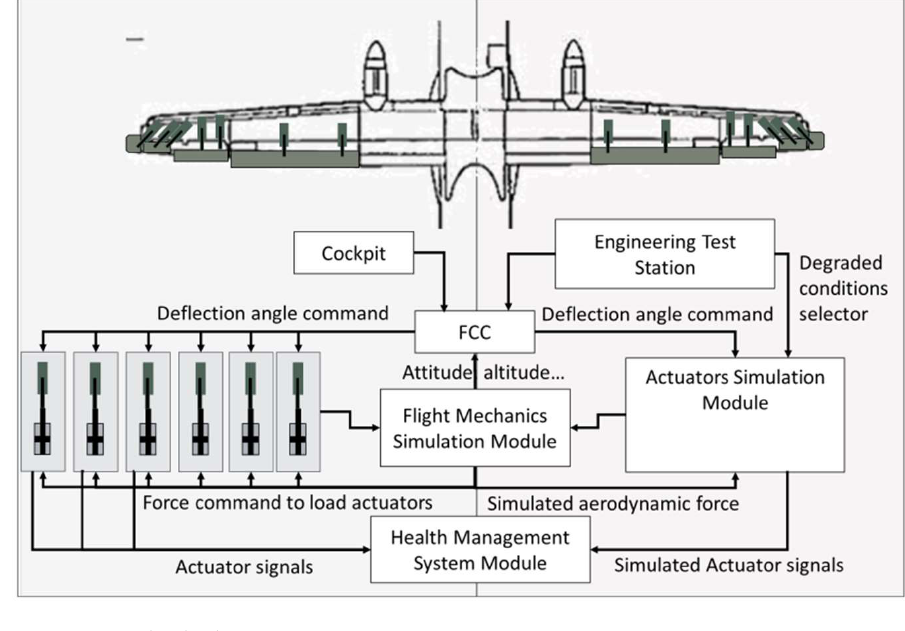
Figure 1. Iron-bird schematics.